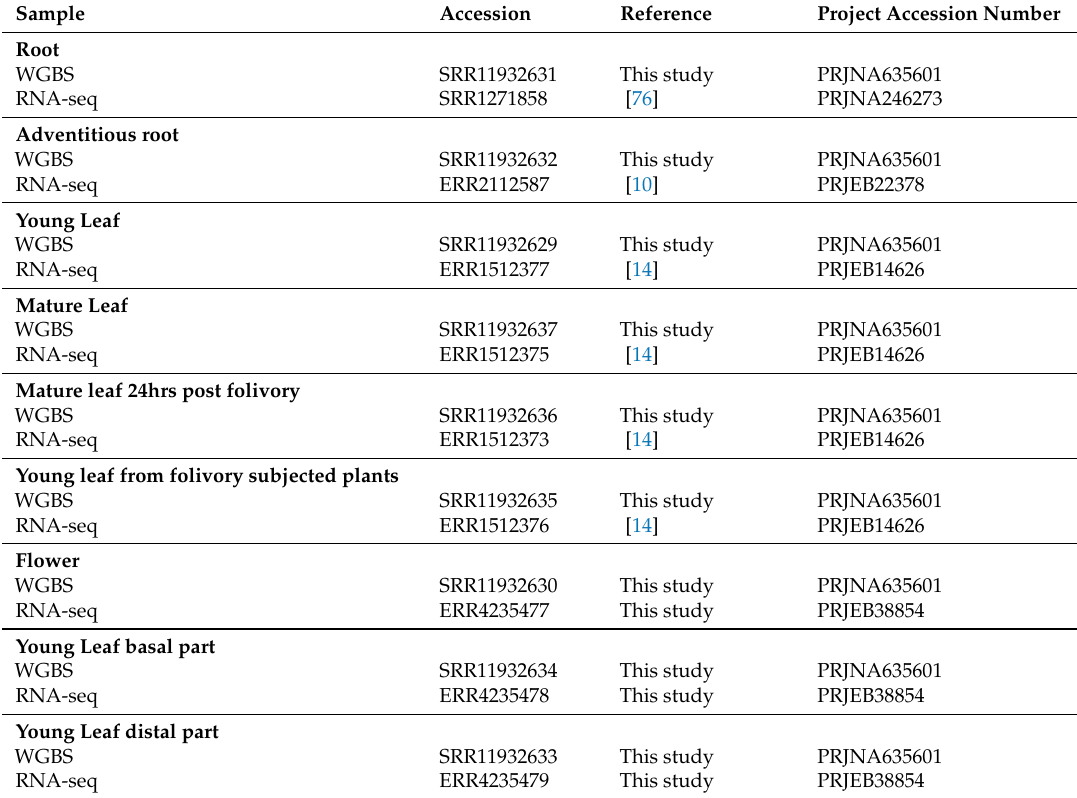
Table 2. WGBS and RNA-seq